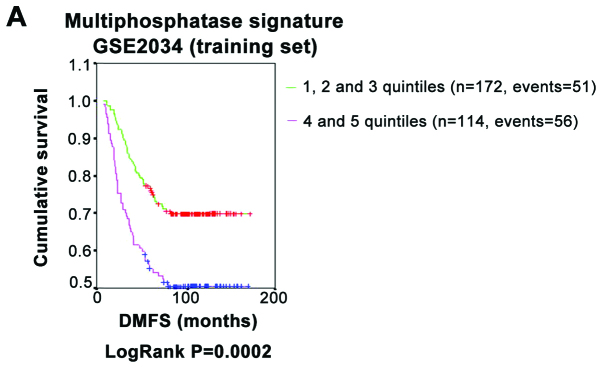
(A) Kaplan-Meier plot of 2 prognostic groups obtained according to the 58 probes (48 genes) multiphosphatase signature trained in GSE2034 and (B) tested in GSE7390.